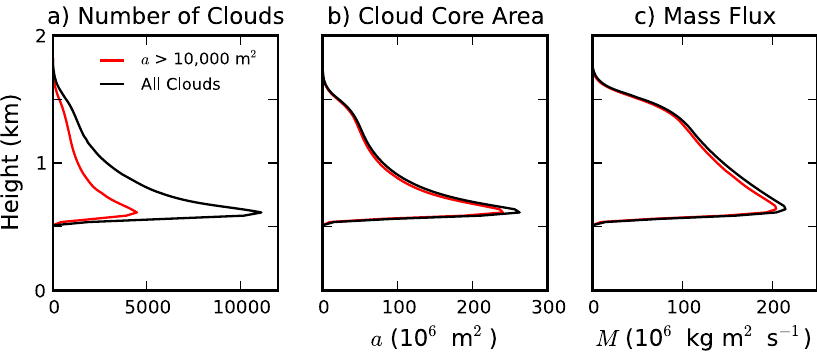
Fig. 2. Vertical profiles of (a) number of cloud core samples, (b) cloud core cross-sectional area, and (c) cloud core vertical mass flux summed over all cloud samples in the entire BOMEX LES run (black line) and all cloud samples with instantaneous cross-sectional area larger than 10000m 2 (red